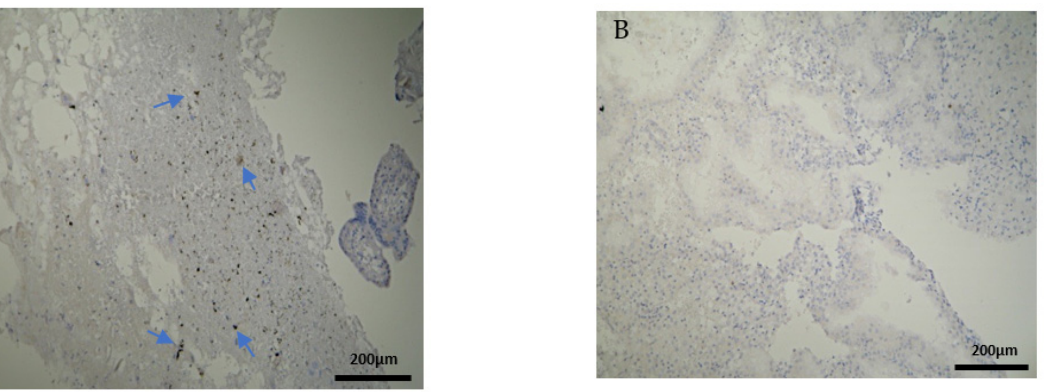
Figure 7 . Evaluation of positive CD20 antigen expression. Miscarriage experimental group (EG): ( Α ) ( A ) Moderate CD20 intensity of staining in the DP (4 × 10 magnification). ( B ) Negative expression of Moderate CD20 intensity of staining in the DP (4 × 10 magnification). ( Β ) Negative expression of CD20 in the DB (4 × 10 magnification). CD20 in the DB (4 × 10 magnification).